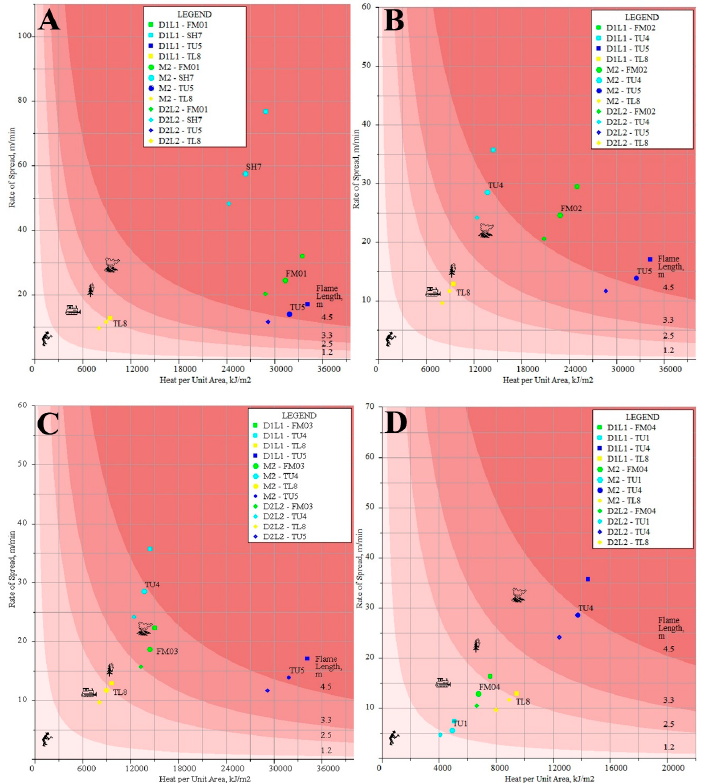
Figure A2. Fire characteristics chart of the simulated fire behavior of: ( A ) the custom fuel model FM01 with the standard fuel models TL8 (Long-Needle Litter), TU5 (Very High Load, Dry Climate Timber–Shrub), and SH7 (Very High Load, Dry Climate Shrub); ( B ) the custom fuel model FM02 with the standard fuel models TL8, TU5, and TU4 (Dwarf Conifer with Understory); ( C ) the custom fuel model FM03 with the standard fuel models TL8, TU5, and TU4; ( D ) the custom fuel model FM04 with the standard fuel models TL8, TU4, and TU1 (Low Load Dry Climate